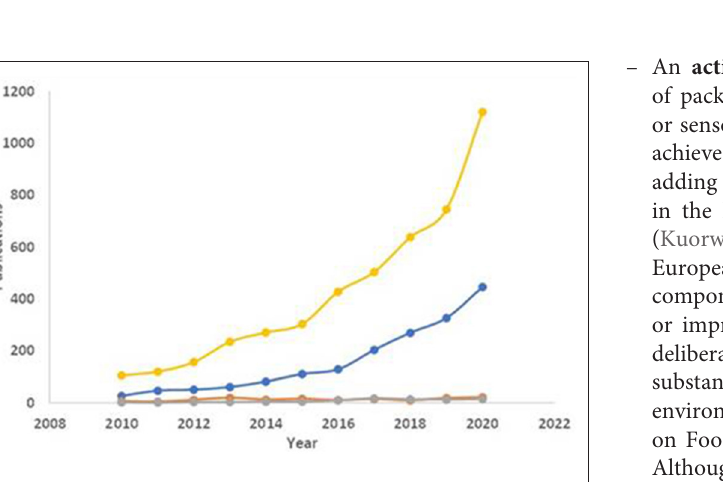
FIGURE 4 | Evolution of the number of publications during the last 10 years (2010–2020) with the terms “renewable + biobased + biodegradable food packaging” ( (cid:4) ), “renewable” ( (cid:4) ), “biobased” ( (cid:4) ), or “biodegradable” ( (cid:4) ) as title and/or topic (Scholar Google, March 2021, http://scholar.google.com).